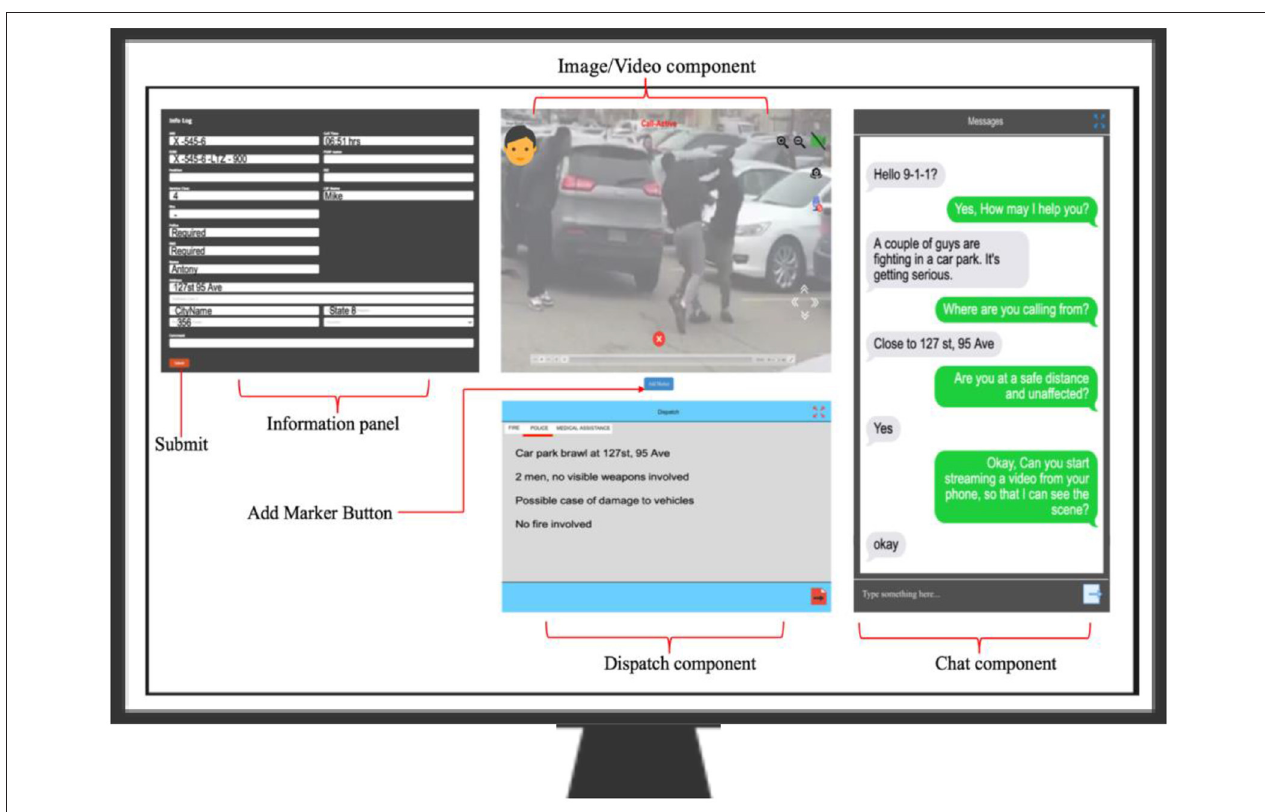
FIGURE 2 | Paper prototype media